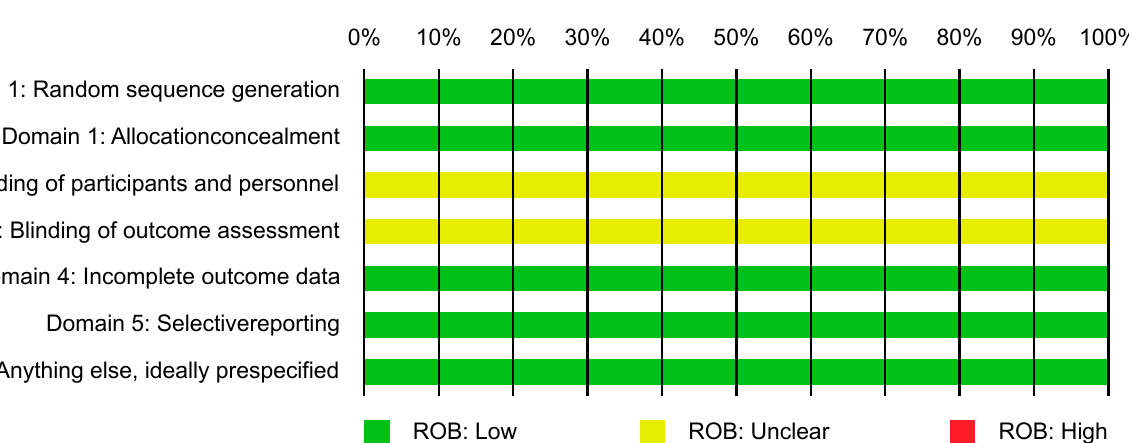
Figure 2. The risk-of-bias assessment graph using Cochrane Collaboration’s Risk of Bias Tool dedicated for human studies (ROB, risk of bias).